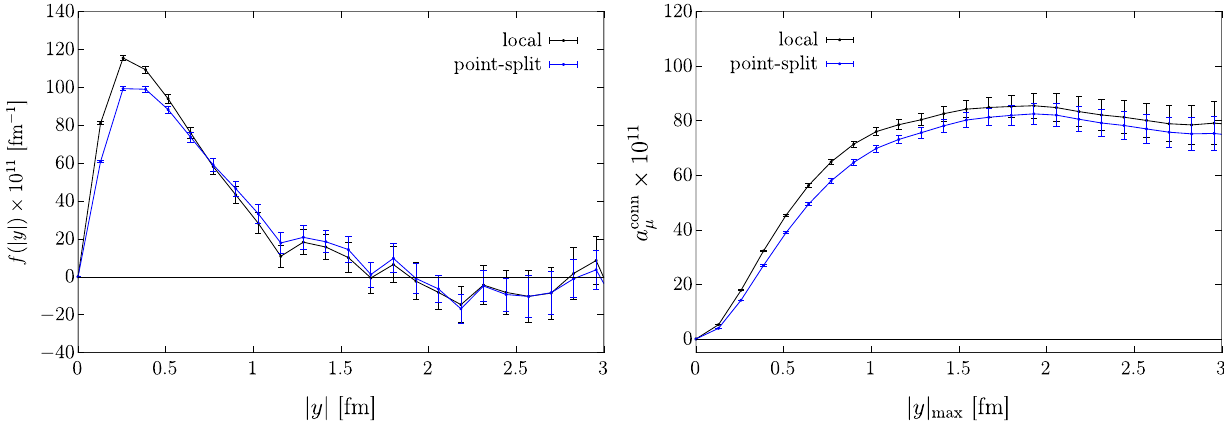
Fig. 8 Results for the ensemble N202 using method 1 with (cid:12) = 0 . 16. Black points use a local current at the site x in Eq. (6) (which is our default approach) and blue points use a conserved current at x . Left: integrand f ( | y | ) as a function of | y | . Right: integrated value of a conn μ as a function of | y |